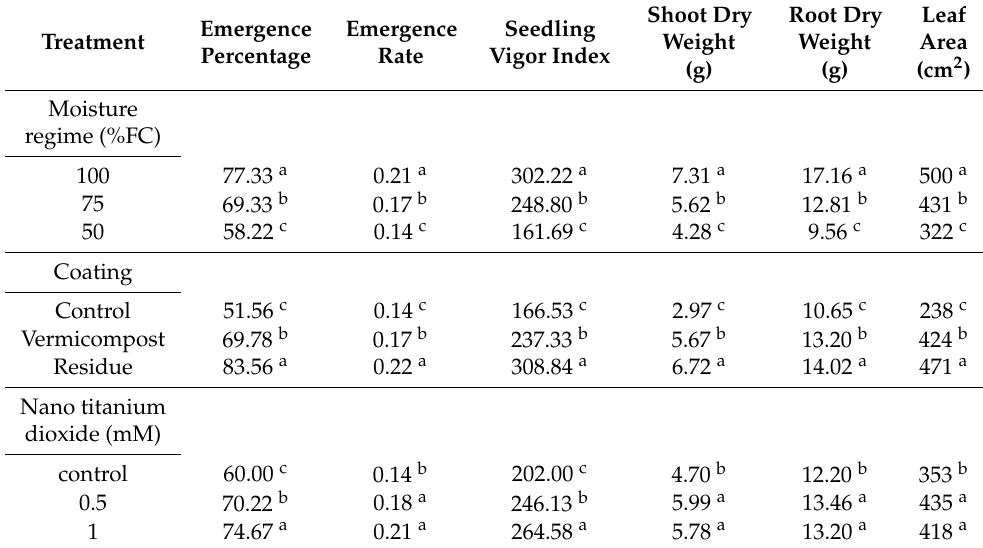
Table 5. Effect of moisture regime, organic coating, and titanium dioxide nanoparticles on emergence